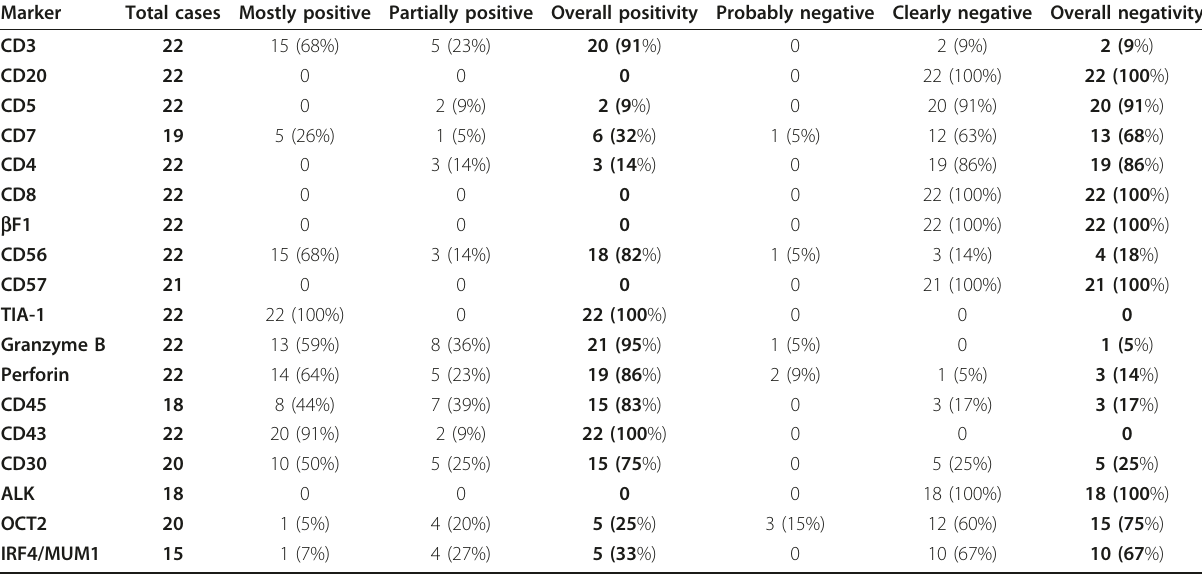
Table 4 Summary of immunohistochemical results of the 22 cases of extranodal NK/T-cell lymphoma, nasal type